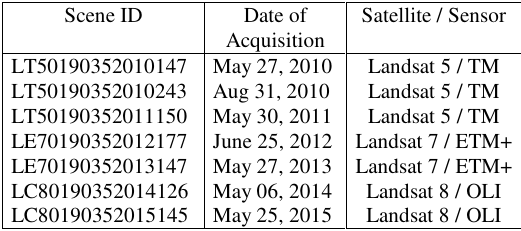
Table 1. Landsat images used in this study The selection of the image associated with baseline conditions used also an analysis of departures from normal water availability based on climate data spanning the period 1980- 2014. For that, we used DAYMET data (Thorton et al., 2014, https://daymet.ornl.gov), which included daily climatological surfaces for precipitation, temperature and downwelling radiation. A map of the vegetation cover of the Great Smoky Mountains National Park produced by the Center for Geospatial Research (Madden et al., 2012) was used to identify the main vegetation types affected by the